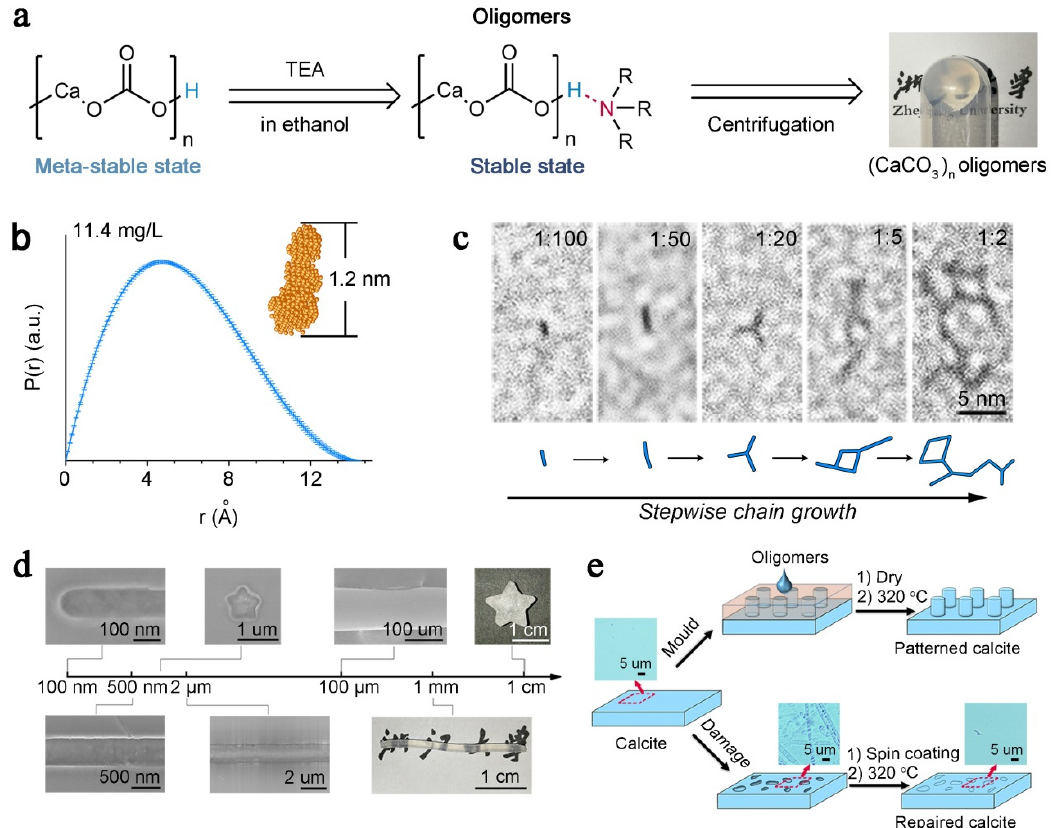
Figure 5. ( a ) Scheme of the capping strategy and reaction conditions for producing (CaCO 3 ) n oligomers; a photograph of gel-like (CaCO 3 ) n oligomers is presented on the right. ( b ) Pair–distance distribution function (P(r)) of the (CaCO 3 ) n oligomers. The shape simulation of the oligomer is shown in the inset. Error bars represent one standard deviation, n = 20. ( c ) high-resolution transmission electron microscope (HRTEM) images of (CaCO 3 ) n oligomers grown at different Ca/triethylamine (TEA) ratios from 1:100 to 1:2. ( d ) Molded CaCO 3 with different dimensions and morphologies. ( e ) Schemes for pattern construction on single-crystalline calcite (top path), and the repair of rough single-crystalline calcite to smooth calcite (bottom path). The insets show optical microscopy images of the calcite surface at different stages: native, corroded, and repaired. Reproduced with permission [76]. Copyright 2019, Springer Nature.